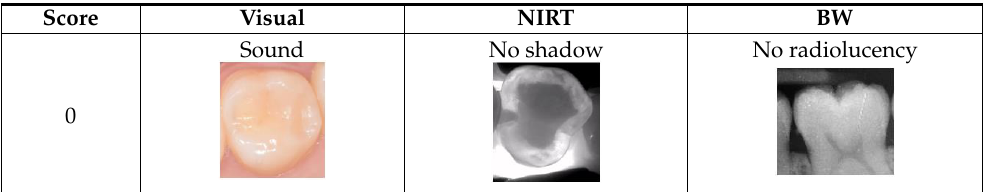
Table 1. Scoring System of the three detection methods used in this study (adapted from Gomez et al. 2015 [34]). Visual evaluation using ICDAS based on clinical images (CI), near-infrared transillu- mination (NIRT), and bitewing radiographs (BW) were scored into 5 categories as described above. Score 1 was considered as early lesions while scores 2, 3 and 4 were considered as distinct lesions. Score Visual NIRT BW Sound 0